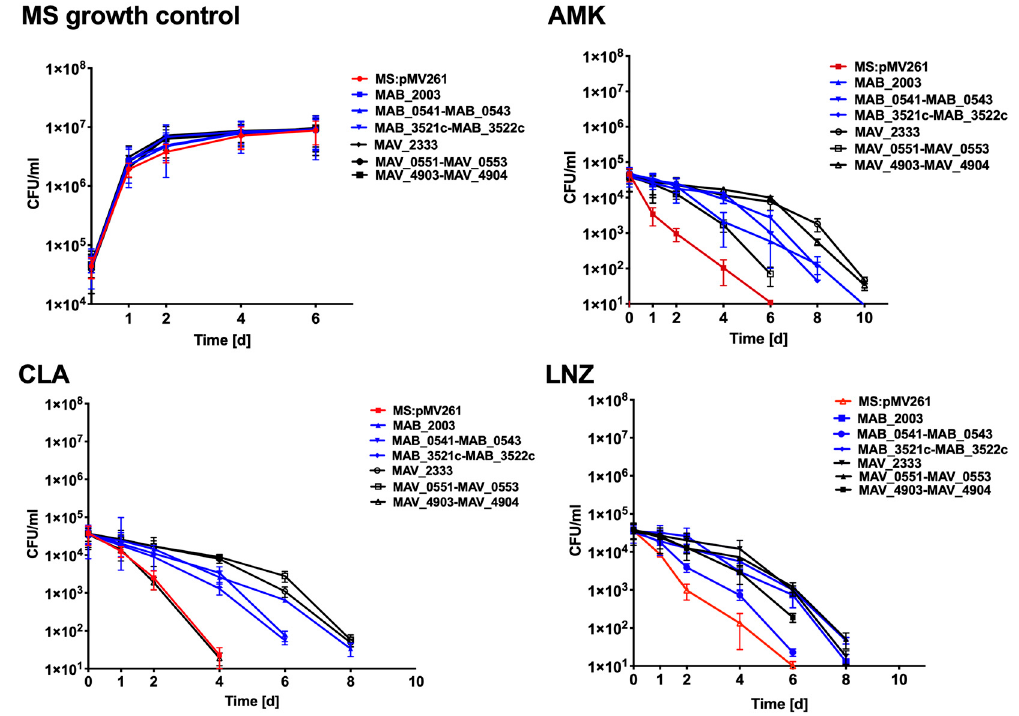
Figure 9. In vitro time-kill curves for M. smegmatis clones expressing MAB and MAH homologues genes of common metabolic pathways. The MAB_2003 and MAV_2333 genes of peptidoglycan